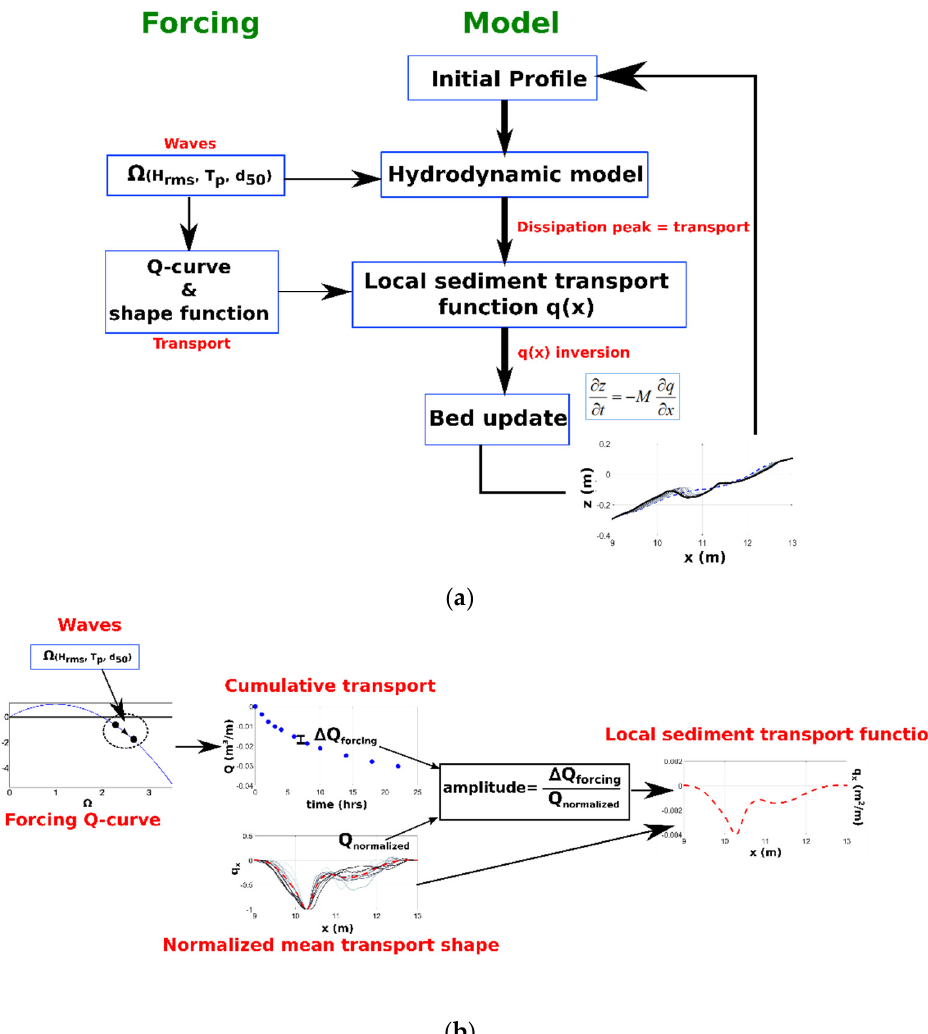
Figure 1. Model steps ( a ) and calculation of the local sediment transport ( b ).